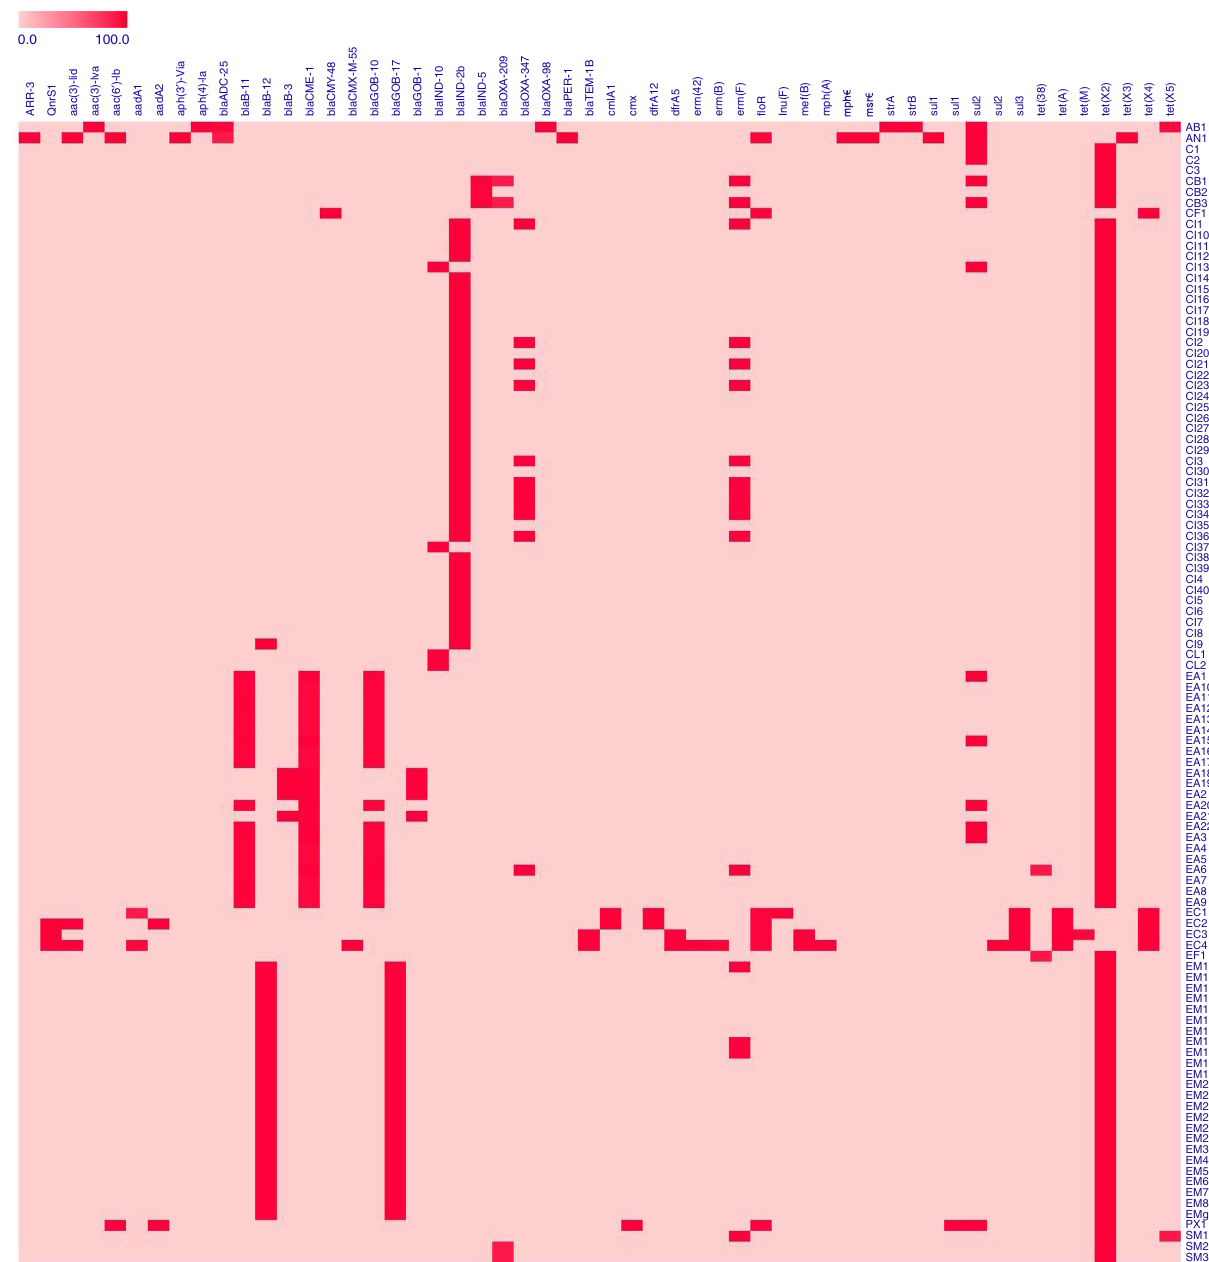
Fig. 2 Heatmap of antimicrobial resistance genes in tet (X)-positive isolates in China. The X axis represents the antimicrobial resistance gene carried by each strain. The Y axis indicates tet (X)-positive strains described in this study. Labels in the Y axis represent the species of the strain, AB Acinetobacter baumannii, AN Acinetobacter nosomialis, C Chryseobacterium sp., CB Chryseobacterium bernardetii, CF Citrobacter freundii, CI Chryseobacterium indologenes, CL Chryseobacterium lactis, EA Elizabethkingia anophelis, EC Escherichia coli, EF Empedobacter falsenii, EM Elizabethkingia meningoseptica, PX Pseudomonas xiamenensis, SM Sphingobacterium mizutaii . Red and pink colors indicate the presence and absence of the corresponding antimicrobial resistance genes,